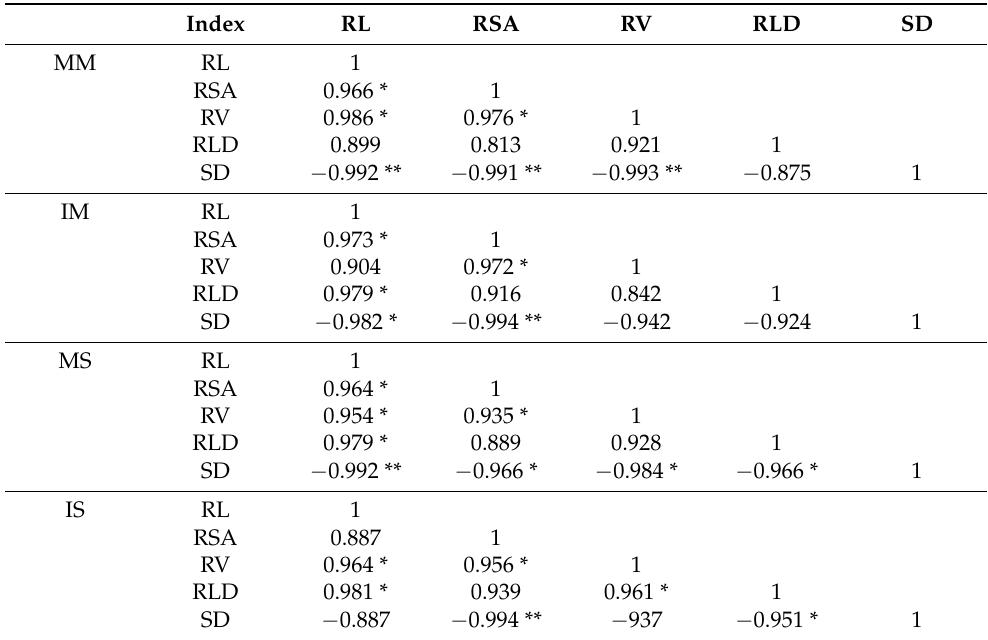
Table 2. Correlation analysis between soil depth and root morphological characteristics in monocrop- ping maize and soybean and maize/soybean.